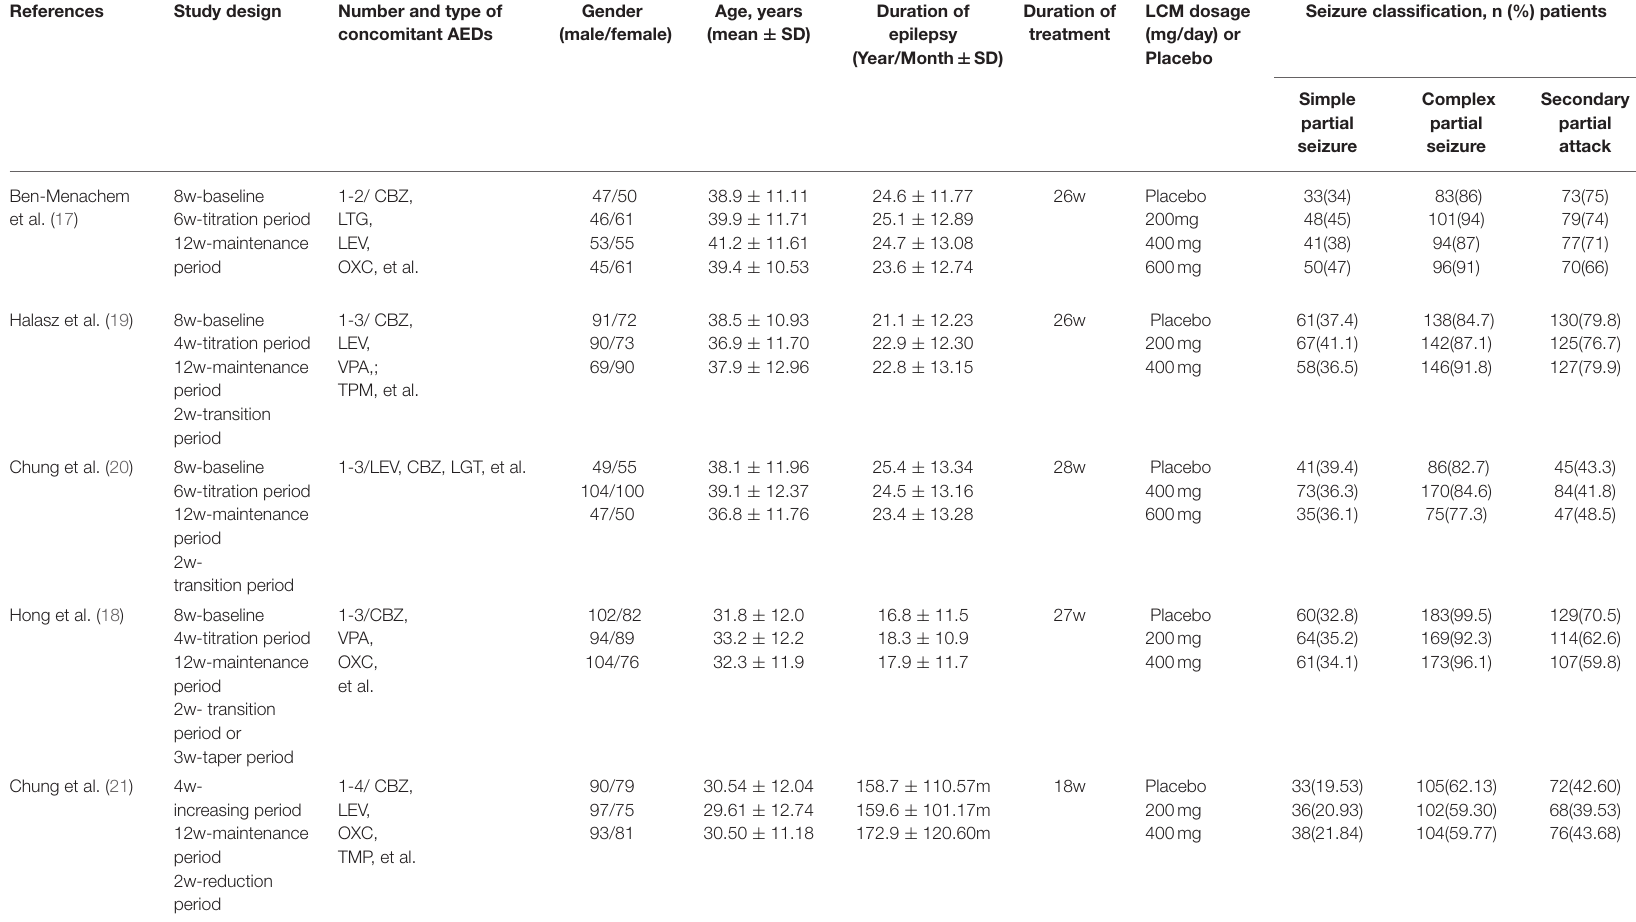
TABLE 1 | Characteristics of the randomized controlled trials included in the present